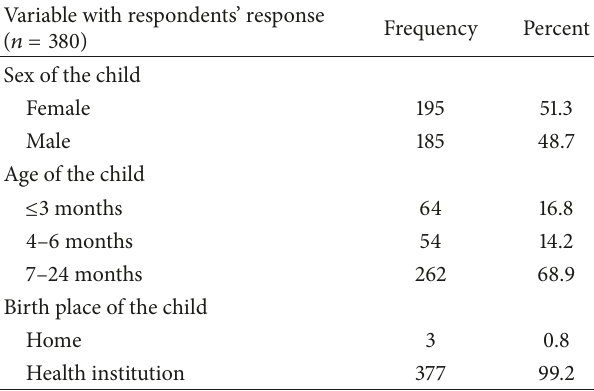
Table 2: Child profile of mothers attending private pediatric clinics, Addis Ababa, Ethiopia, March–May